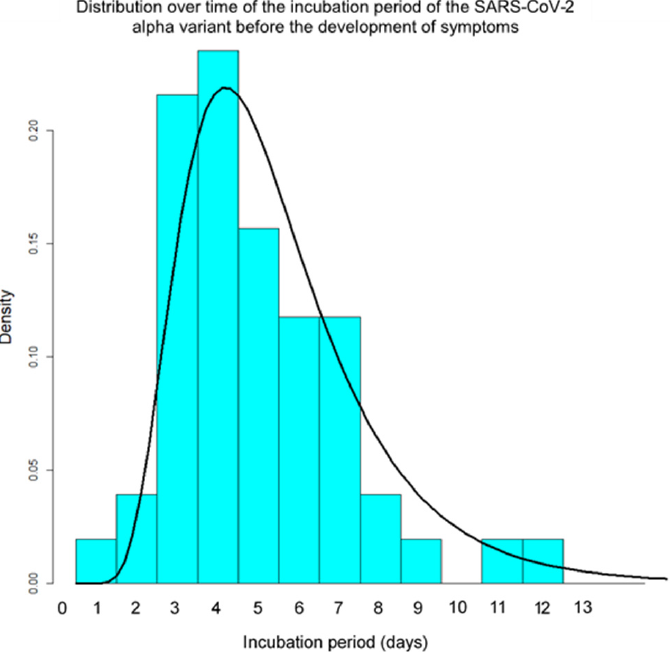
Figure 3. Probability density of the incubation period of the Alpha variant of SARS-CoV-2 using the log-normal distribution (solid line) in 51 cases diagnosed between 10 April and 10 May 2021 in Ja- pan.